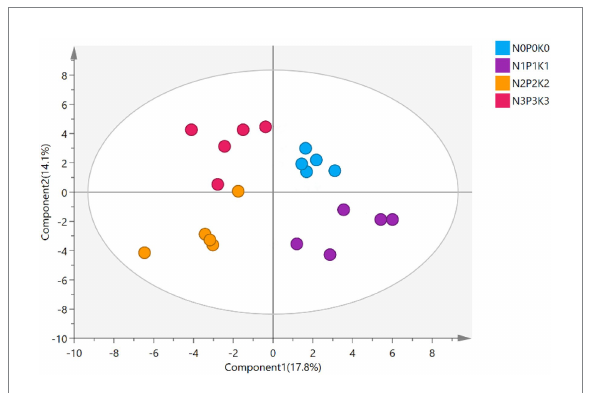
FIGURE 4 The partial least squares-discriminant analysis (PLS-DA) of soil metabolites under different fertilization levels.